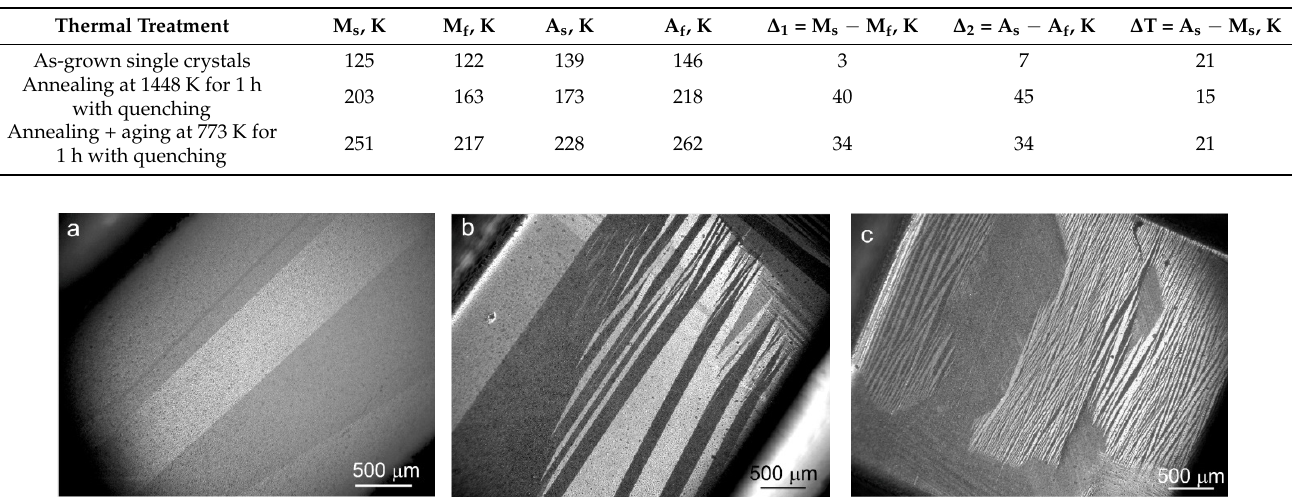
Figure 3. Optical metallography of the surface of the [001]-oriented Ni 44 Fe 19 Ga 27 Co 10 single crystals upon in situ cooling: ( a )—as-grown single crystals, ( b )—quenched single crystals, ( c )—crystals after aging at 773 K for 1 h. Table 1. Characteristic MT temperatures for Ni 44 Fe 19 Ga 27 Co 10 as-grown single crystals, after quench- ing and aging.